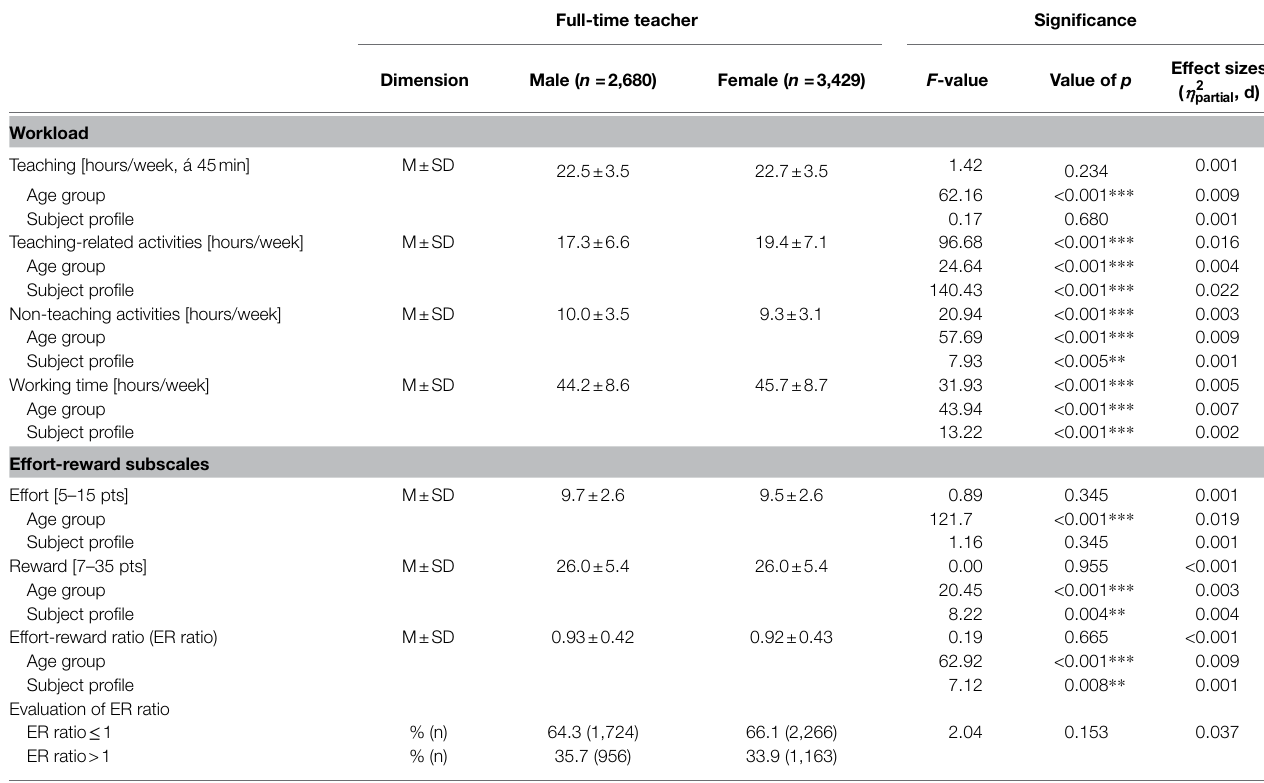
TABLE 2 | Main effects of work-related characteristics and covariates (age groups and subject profile) for male and female full-time teachers.